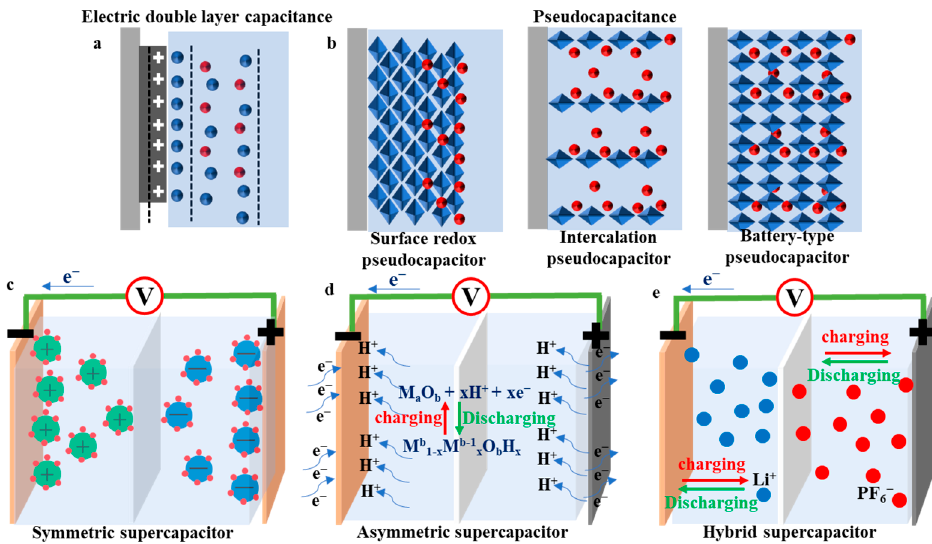
Figure 2. Schematic illustration of ( a ) EDLCs; ( b ) pseudocapacitance type of supercapacitor energy storage mechanisms; ( c ) symmetric supercapacitors; ( d ) asymmetric supercapacitors, ( e ) hybrid supercapacitors type of supercapacitor.